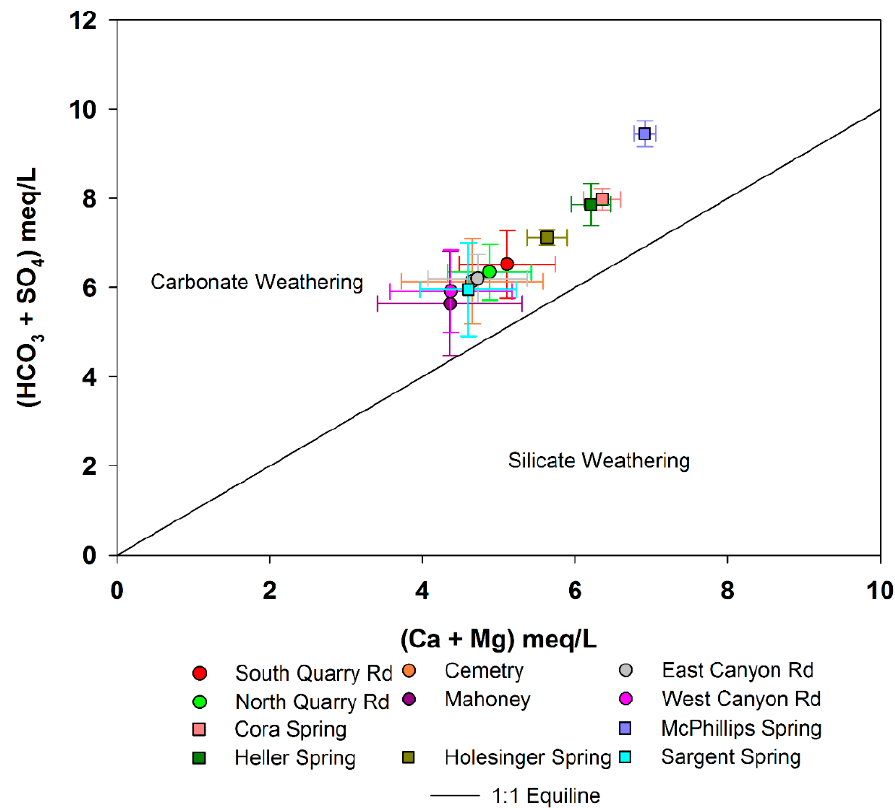
Figure 5. Calcium and magnesium (meq/L) versus bicarbonate and sulfate (meq/L) for the stream (circle) and spring (square) waters showing the carbonate weathering and silicate weathering zones defined by Datta and Tyagi [56] and Lakshmanan, et al. [57] . Points represent the mean value and the error bars indicate a standard deviation for the given location.